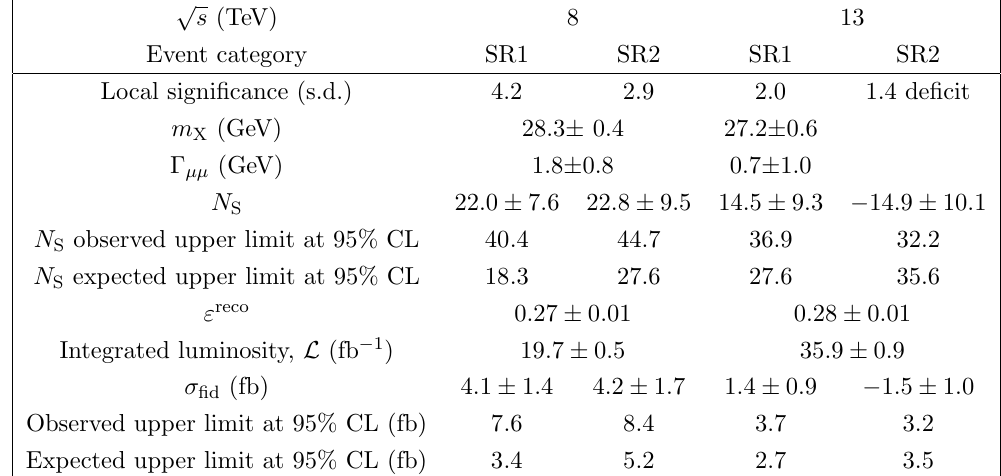
Table 3 . The local signi(cid:12)cances, the mass and the width of the event excess, the measured (cid:12)ducial cross sections with (cid:6) 1 s.d. uncertainties, and the 95% CL upper limits on those. The best (cid:12)t N S values for the two SRs and the 95% CL upper limits on those, the reconstruction e(cid:14)ciencies and the integrated luminosities are also